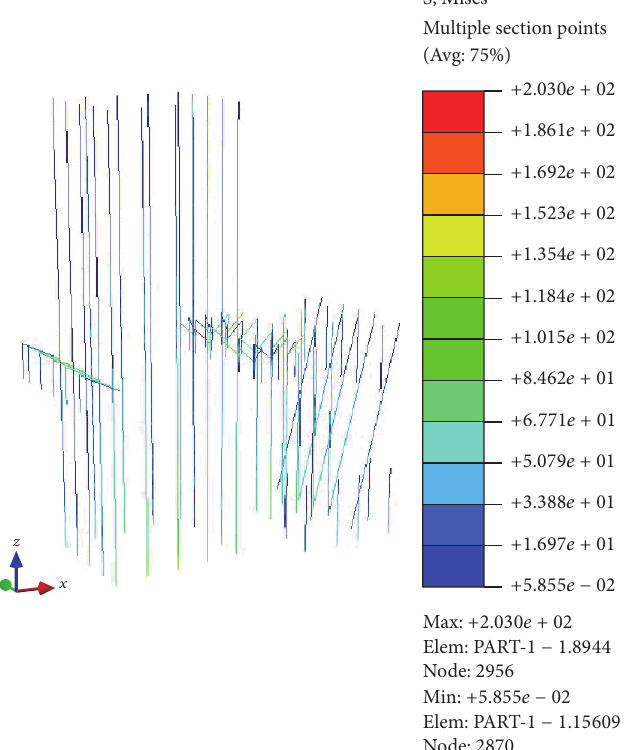
Figure 26: Mises stress of the frame columns and belt truss of connecting members under rare intensity 7 earthquakes